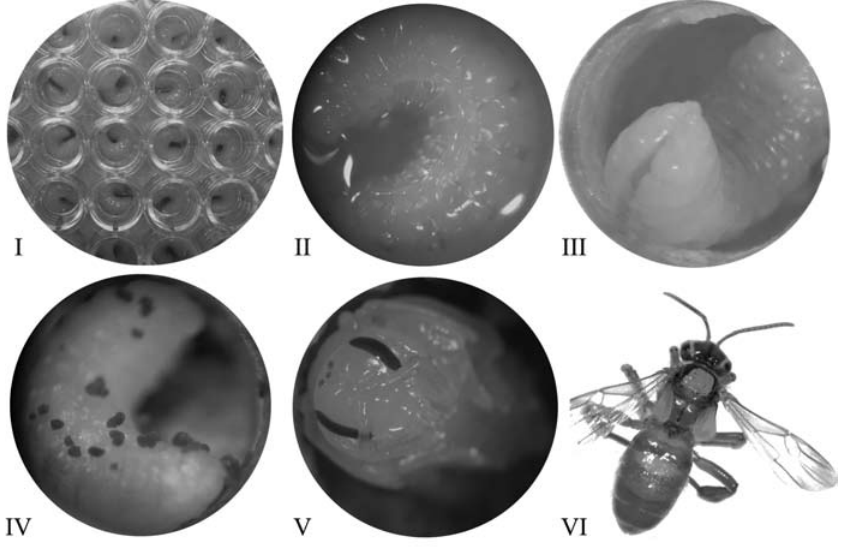
Fig. 2. (I) Larvae of Frieseomelitta varia transferred to artificial cells (Elisa-type acrylic plate). Immature developmental stages in vitro : (II) feeding larva; (III) final feeding phase; (IV) defecation phase, (V) queen pupa phase and (IV)